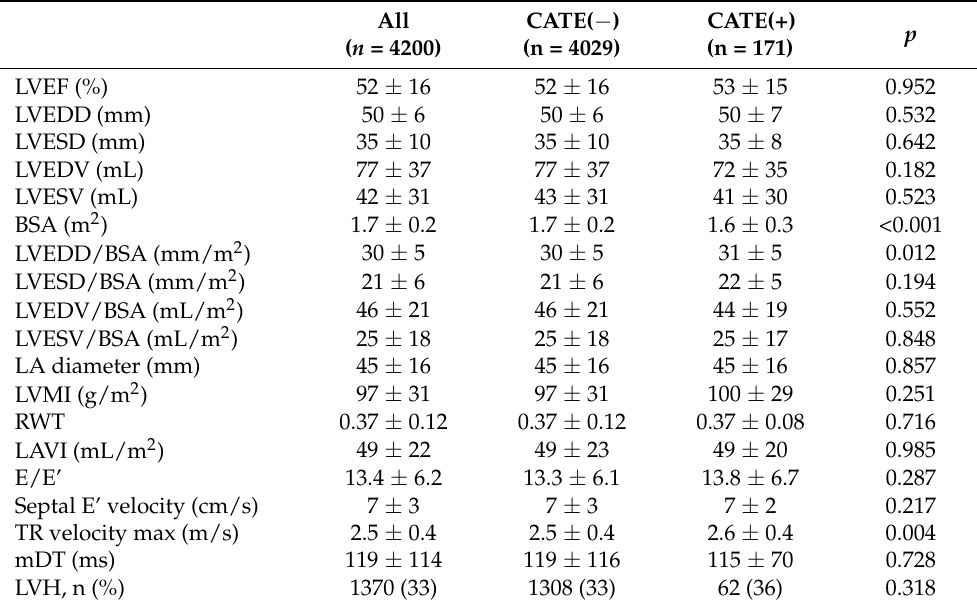
LVH, n (%) 1370 (33) 1308 (33) 62 (36) 0.318 LVEF, ejection fraction; LVEDD, left ventricular end diastolic dimension; LVESD, left ventricular end systolic dimension; LVEDV, left ventricular end diastolic volume; LVESV, left ventricular end systolic volume; BSA, body surface area; LA, left atrial; LVMI, left ventricular mass index; LAVI, left atrial volume index; E/E’, the ratio of early diastolic mitral inflow velocity to early diastolic velocity of the mitral annulus; RWT, relative wall thickness; mDT, mitral deceleration time; LVH, echocardiographic left ventricular